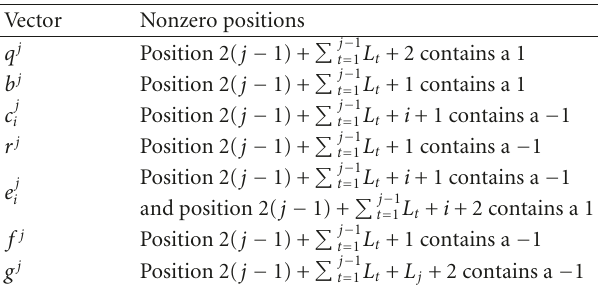
(cid:6) J table has a dimension of L j + 2 J , which contains only zeros j = 1 except for the specified positions.